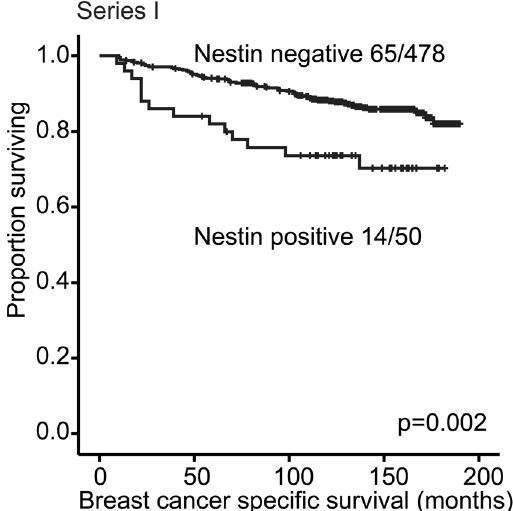
Figure 3. Breast cancer specific survival according to Nestin status. Kaplan-Meier univariate breast cancer specific survival analysis in Series I according to Nestin protein expression (log-rank test for difference). For each category, the number of breast cancer deaths is given, followed by the total number of cases in each category.